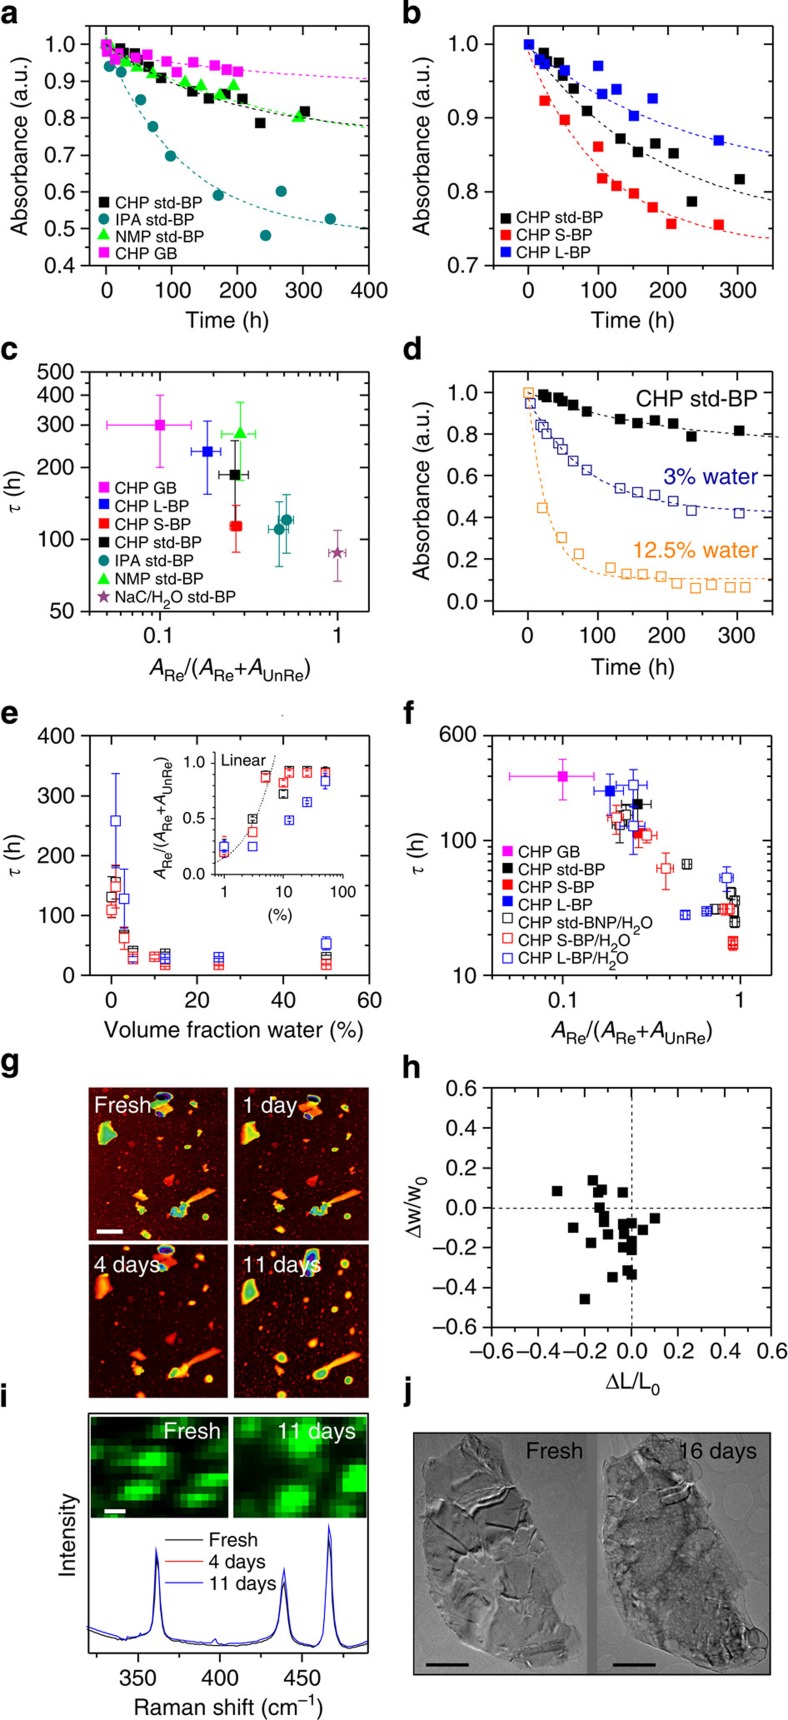
Stability of exfoliated black phosphorous nanosheets.(a,b) Relative absorbance at 465 nm, measured as a function of time, for (a) the standard FL-BP dispersion (std-BP) exfoliated in CHP, NMP and IPA, as well as BP exfoliated in CHP in a glovebox (CHP GB) and (b) std-BP in CHP compared with size-selected dispersions containing small (S-BP) and large nanosheets (L-BP). The dashed lines represent exponential decays: A=AUnRe+ARee−t/τ, where ARe represents the component of BP, which reacts with water/O2, AUnRe represents the unreacted component and τ represents the reaction timescale. (c) Reaction timescale, τ, plotted versus the fraction of BP which reacts, ARe/AUnRe+ARe, for a number of different systems. (d) Fitted time-dependent absorbance (465 nm) data for std-BP in CHP and std-BP dispersions with 3 vol% and 12.5 vol% of water added. (e) Plot of τ versus volume fraction of added water. The inset shows the fraction of unstable BP plotted versus water content. The dashed line demonstrates this fraction to scale initially linearly with water content. (f) Plot of τ versus ARe/AUnRe+ARe for BP exfoliated in CHP with and without the addition of water. (g) Sequence of AFM images of the same sample region of an as-prepared sample, and after 1, 4 and 11 days of exposure to ambient conditions, respectively (scale bar, 600 nm). Errors in c,e,f are statistical errors associated with the fits. (h) Map showing both fractional length, L, and width, w, changes as measured by AFM immediately after exfoliation after day 4. Negative values of Δw/w0 and ΔL/L0 indicate that the nanosheets are getting smaller over time. (i) Mean Raman spectra (633 nm excitation) summed over the same sample region of an as-prepared sample, after 4 days and 11 days, respectively. Spectra are normalized to the silicon peak at 521 cm−1. Inset: Raman A1g intensity map of the sample region (freshly prepared and after 11 days). (j) TEM images of the same flake deposited from a freshly prepared dispersion and after 16 days.